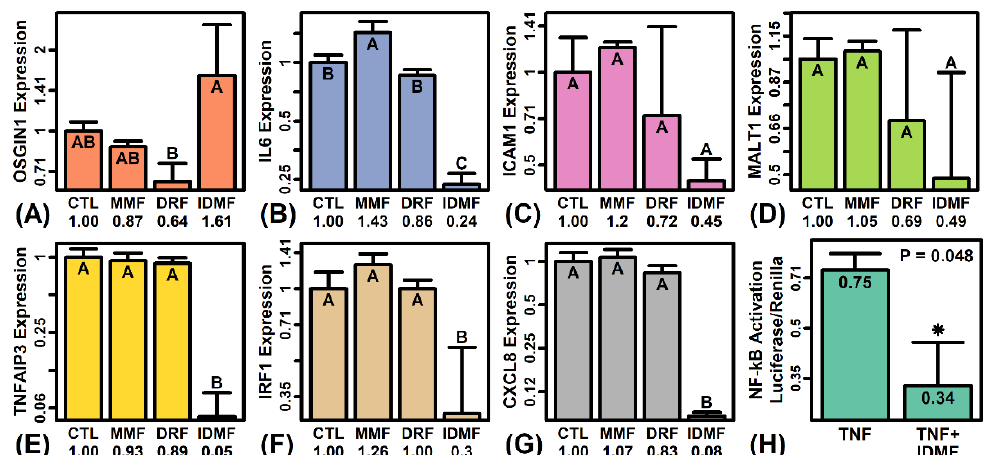
Figure 8. RT-PCR analyses and NF-κB luciferase reporter assay. ( A – G ) RT-PCR analyses ( OSGIN1 , IL6 , ICAM1 , MALT1 , TNFAIP3 , IRF1, and CXCL8 ). Average relative expression is shown for each gene (±1 standard error; n = 3 replicates per treatment). Relative expression was calculated using the 2 −∆∆Ct method and ∆Ct values were further normalized to the CTL treatment. Average relative expression is shown for each treatment (bottom margin). Treatments with different letters have significantly different average expression ( p < 0.05, Fisher’s least significant difference). ( H ) NF-κB reporter assay. Human fetal astrocytes were transfected with firefly/Renilla luciferase constructs and treated with TNF-α (20 ng/ml) alone ( n = 6) or TNF-α (20 ng/mL) + IDMF (2.5 μM) ( n = 3) for 6 h. The ratio of luciferase and Renilla (internal control) signals was used to monitor NF-κB induction. The average ratio value is shown (±1 standard error) for each treatment ( p -value: two-sample Wilcoxon rank sum test).